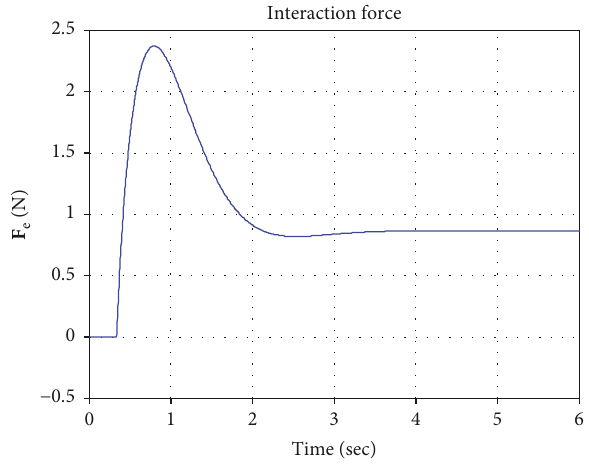
Figure 17: Position of the UAV in the inertial frame.